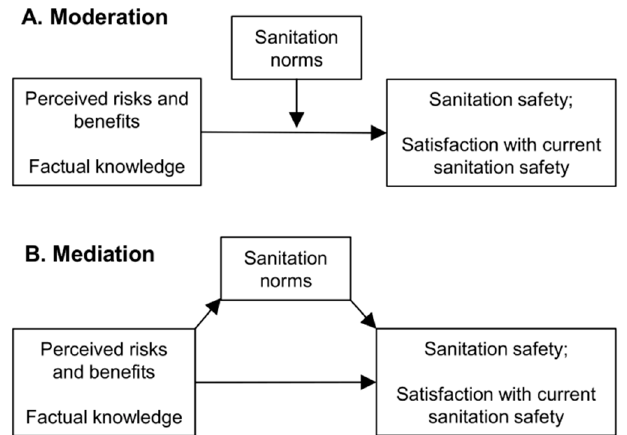
Figure A1. Conceptual diagrams of moderating and mediating role of social sanitation norms (Hypothesis 3). While moderation (A) focuses on how the effect of perceived risks and benefits or factual knowledge changes for different levels of sanitation norms, mediation analysis (B) examines an indirect effect of perceived risks and benefits or factual knowledge through sanitation norms.